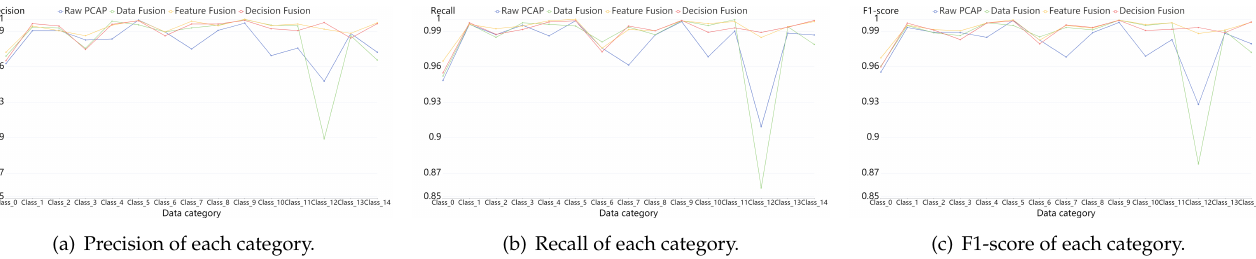
(a) Precision of each category. Figure 14. Classification results of each category on dataset CIC. They are composed of Precision, Recall and F1-score which are calculated by a simple model with PCAP data, data fusion model, feature fusion model and decision fusion